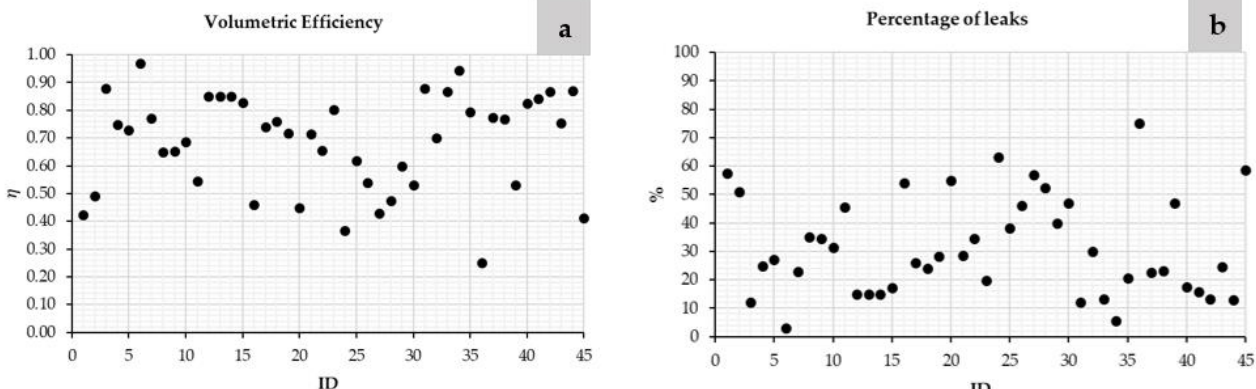
Figure 2. Volumetric efficiency ( a ) and percentage of leaks ( b ).